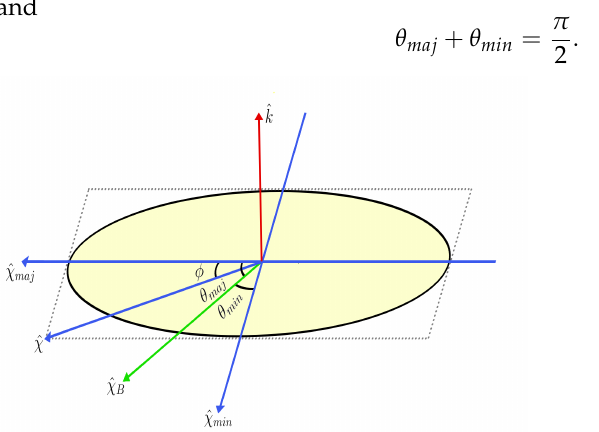
Figure 1. Representation of elliptically polarized laser beam swept out by the laser’s polarization vector in one period. ˆ χ represents the laser’s complex polarization vector and ˆ k as the laser wave vector perpendicular to quantization axis ˆ χ B . The vectors ˆ χ maj , ˆ χ min and ˆ k are mutually perpendicular to each other. Here, θ p is the angle between quantization axis ˆ χ B and direction of polarization vector ˆ χ and the parameters θ maj and θ min are the angles between respective unit vectors and ˆ χ B